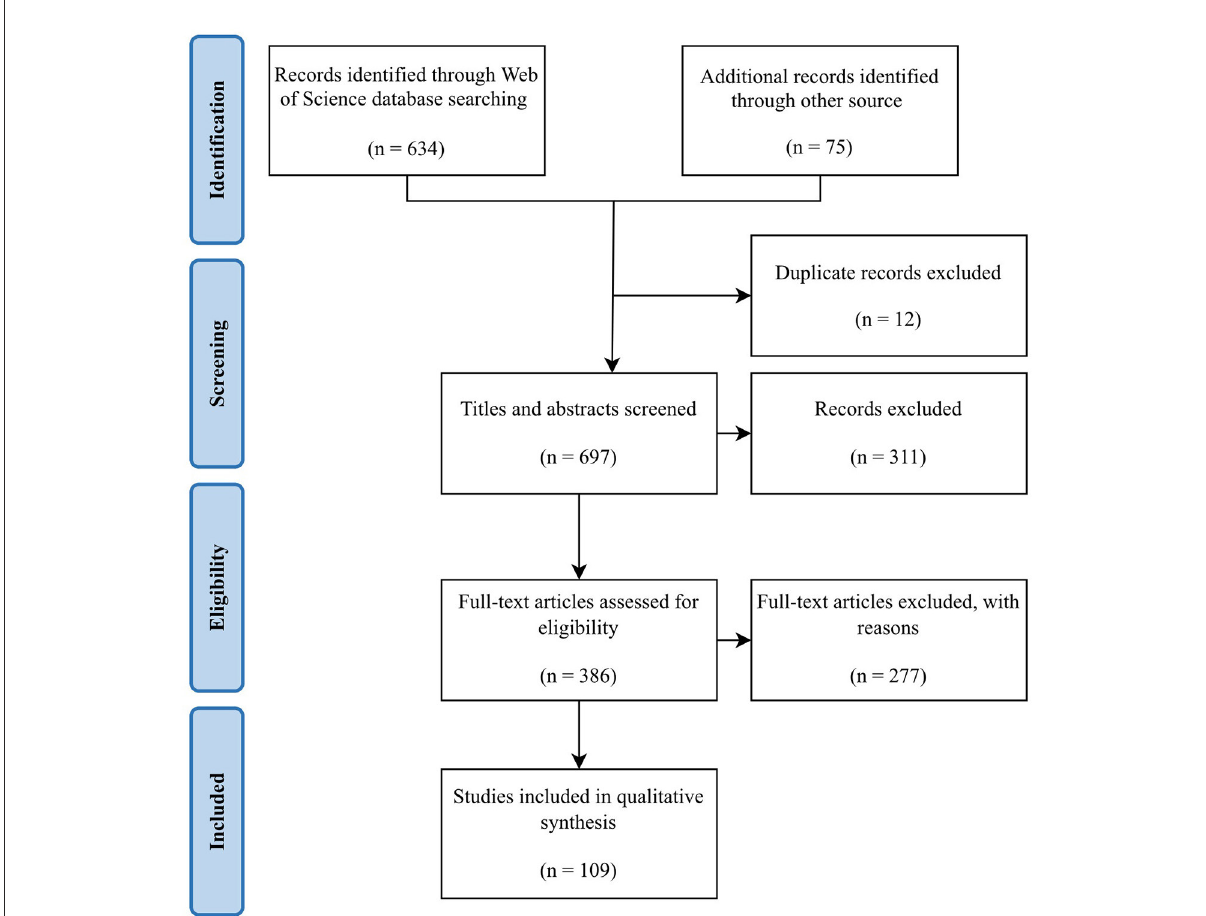
FIGURE1 Search approach detailing the number of records identified, included and